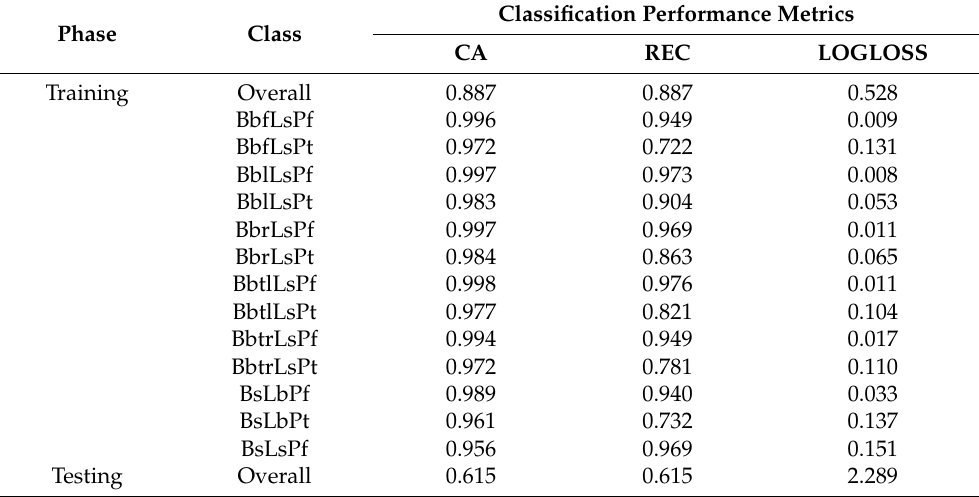
Table 4. Classification performance in the training and testing phases to differentiate the postures of the back by an RF machine learning algorithm with 10,000